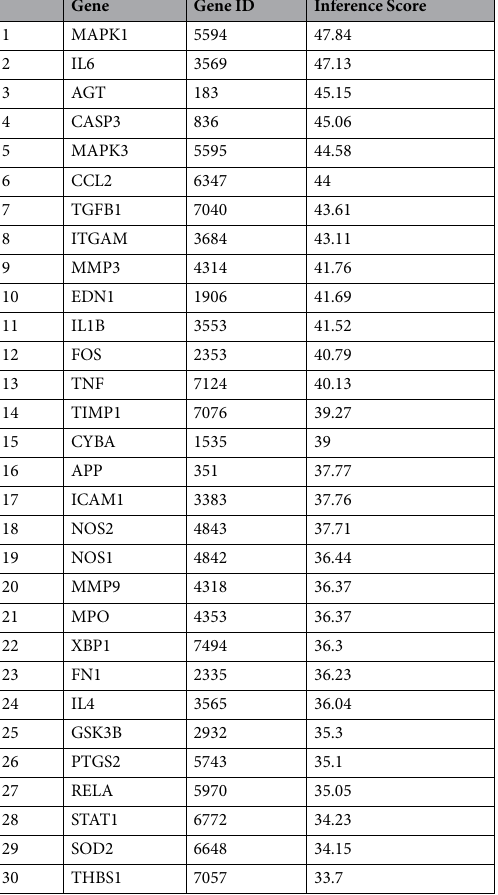
Table 1. The top 30 genes associated with spinal cord injury (SCI) from the Comparative Toxicogenomics Database (CTD) and genes associated with SCI (GAS30).